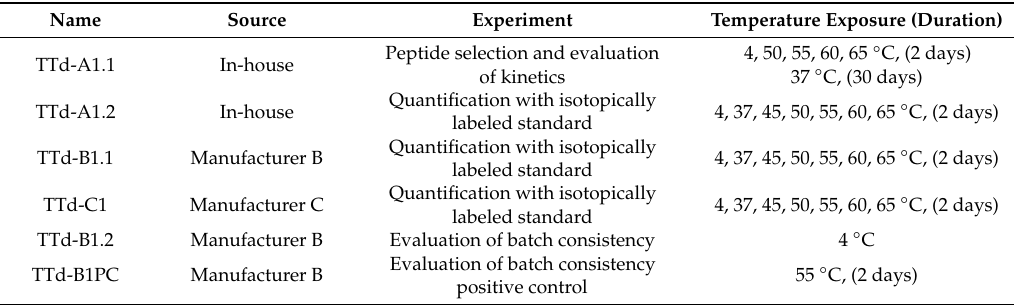
Table 1. Overview of the tetanus toxoid batches used in this